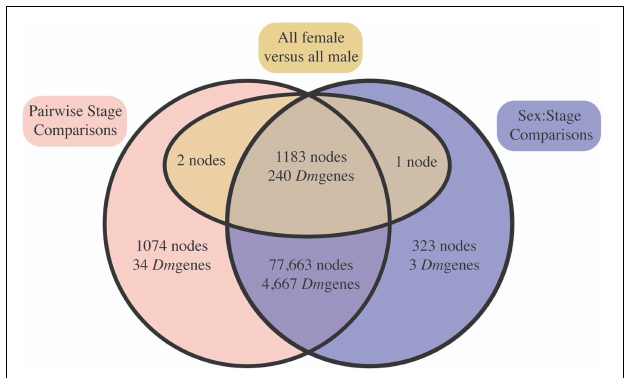
FIGURE 4 | Most differentially expressed nodes were significant in both stage (red) and sex:stage interaction (blue) contrasts, suggesting that there is broad differential expression across both development and in a sex-significant manner. This is supported by the fact that most of the nodes significant between all male and all female samples pooled across immature development (yellow) were also significant in at least one stage specific contrast. Node identities can be found in Supplementary Material 6